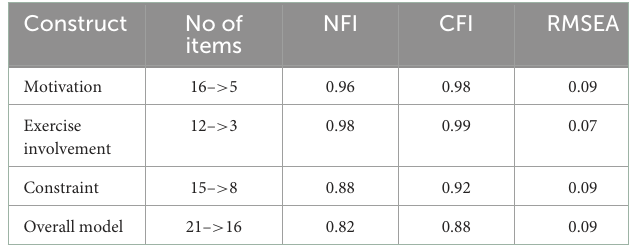
Table 8 indicates that motivation ( β = 0.11 ∗∗ ) has a significantly positive impact on WTP, supporting Hypothesis 1.